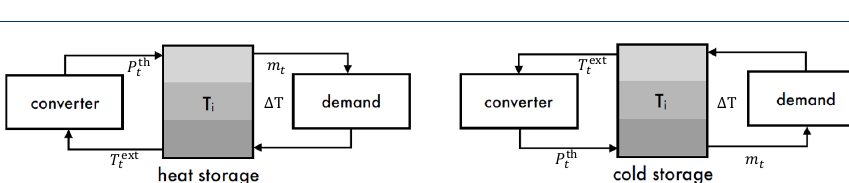
Figure 1 E(cid:11)ect of equation 5 on thermal power output (left) and converter e(cid:14)ciency (right).